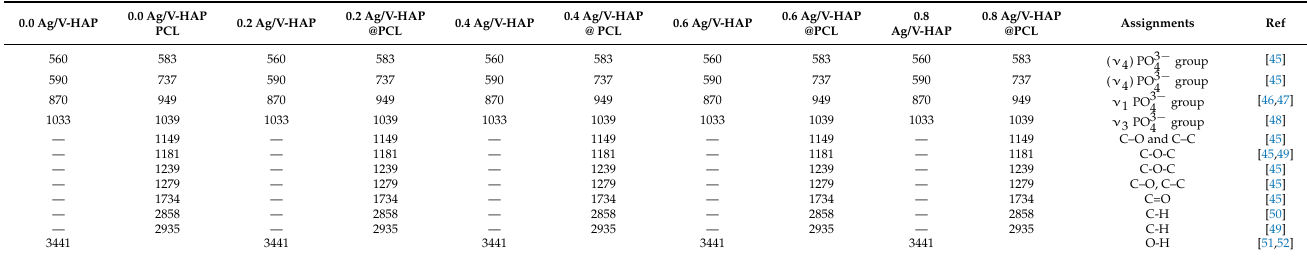
Table 1. Characteristic FTIR bands of Ag/V-HAP and Ag/V-HAP@PCL at different silver ions concentrations. 0.0Ag/V-HAP 0.0Ag/V-HAP PCL